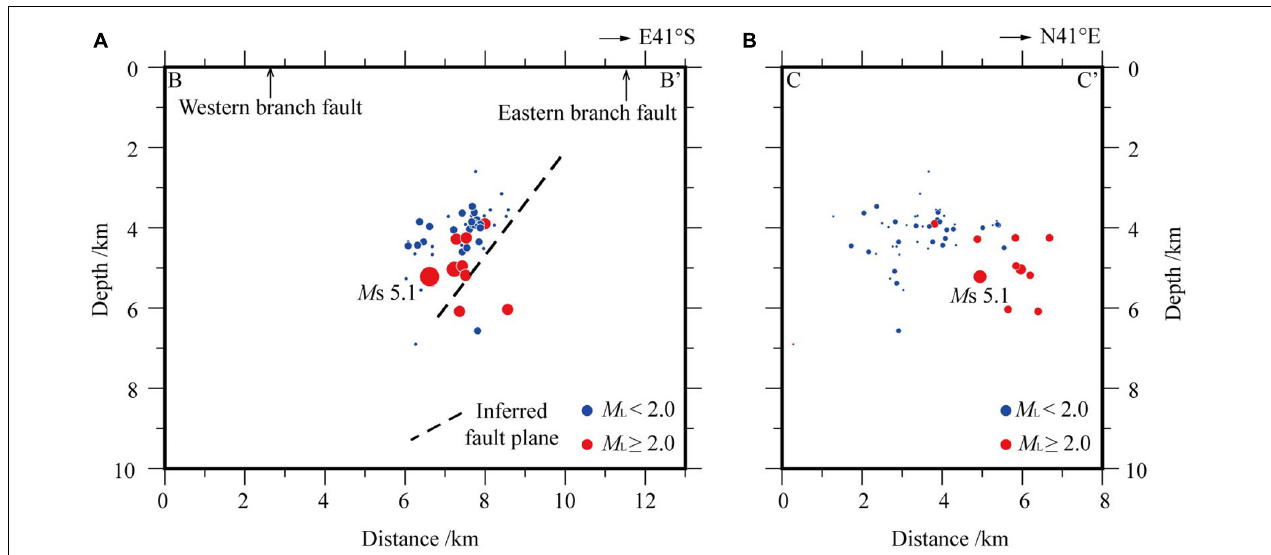
FIGURE 6 | Vertical cross-sections of the M S 5.1 Qingbaijiang earthquake sequence. (A) Cross-section B–B’, along the short axis of the M S 5.1 sequence. This profile highlights a NW-dipping feature that appears to meet the eastern branch fault if it is extended to the surface. (B) Cross-section C–C’, along the long axis of the M S 5.1 sequence. This profile shows a northward deepening of the earthquake sequence, with smaller aftershocks in the southern part and larger aftershocks in the northern part.